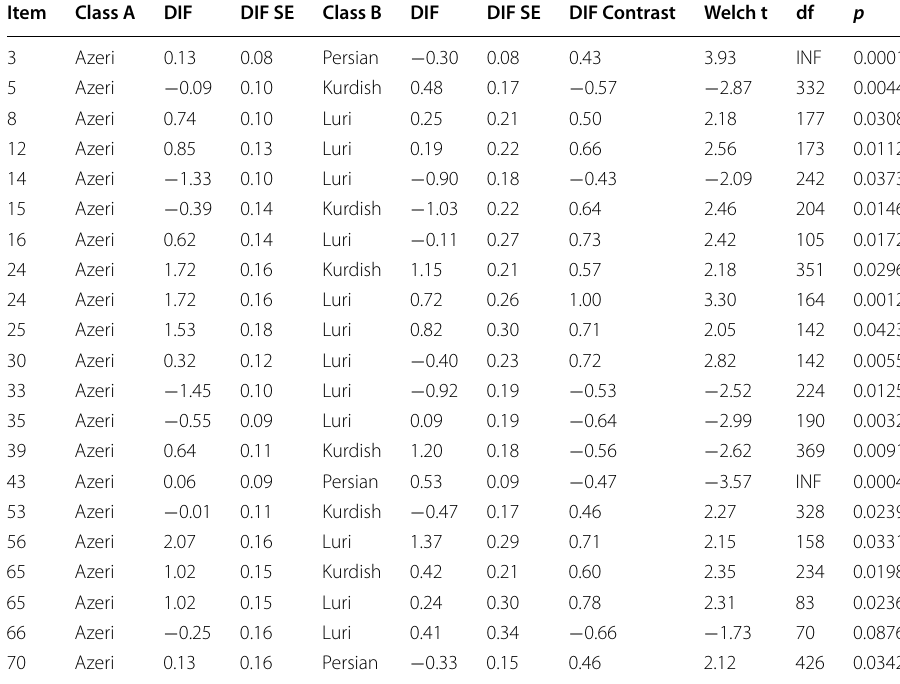
Table 6 Results of uniform DIF analysis of items (IUUESEE 2017) Item